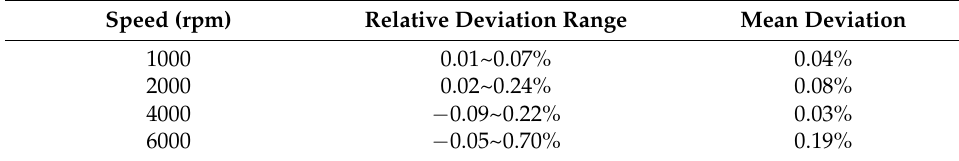
Figure 14. The heat transfer simulation of the cap head: ( a ) the T r3 values at 1000 rpm; ( b ) the T r3 values at 2000 rpm; ( c ) the T r3 values at 4000 rpm; ( d ) the T r3 values at 6000 rpm. Table 3. Deviations of simulation values to experimental values of T r3